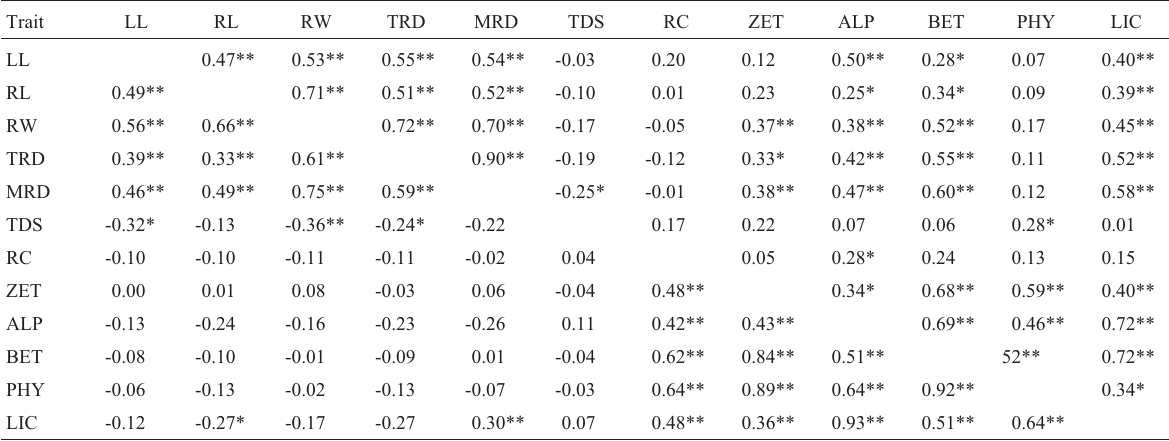
Table 1 - Phenotypic correlations between some morphological traitsand major carotene contentin two different F 2 carrot populations. Upper diagonal = Brasilia x HCM, lower diagonal = B493 x QAL.